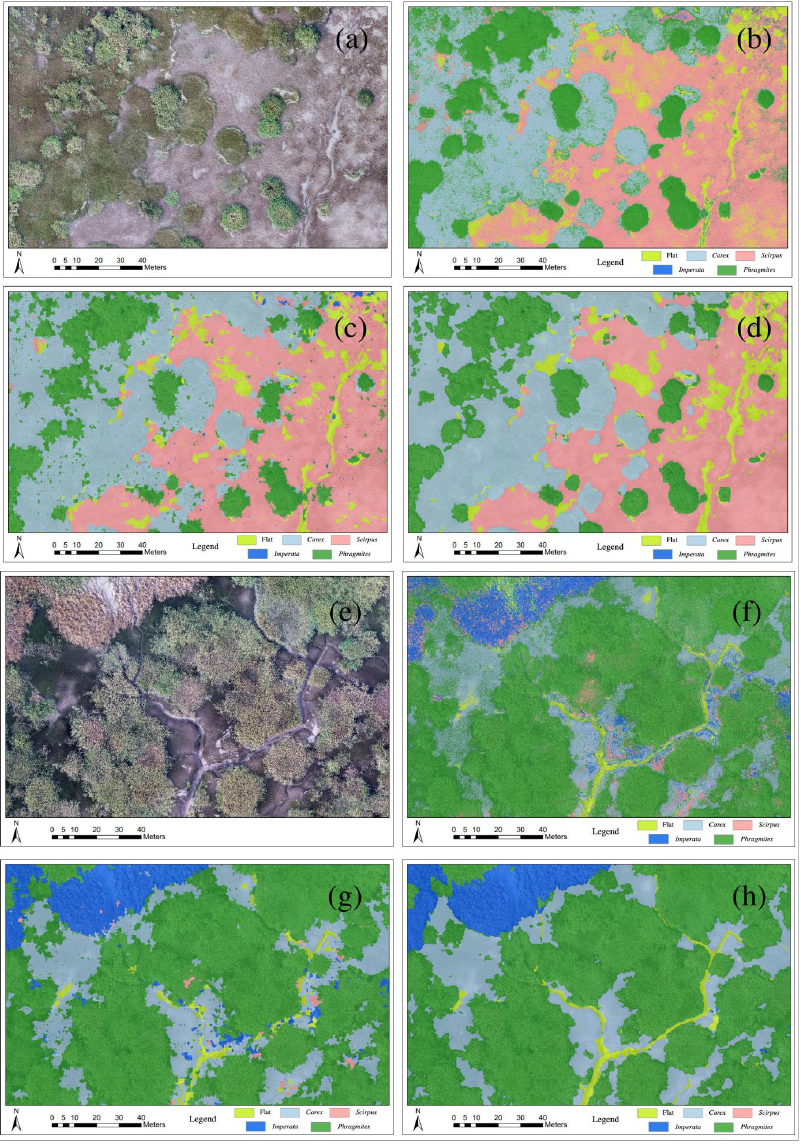
Figure 7. Detailed comparison of vegetation classification using PB, OBIA, and DL methods based on RGB-UAV in the high ( a – d ) and low ( e – h ) tide flat of study area. ( a , e ) are UAV-RGB images, ( b , f ) are the result of PB classification, ( c , g ) are the result of OBIA classification, and ( d , f ) are the result of DL classification. All features (RGB + VI + Texture + DSM) were utilized in PB and OBIA methods. For the DL model, the classification results are predictions in the test